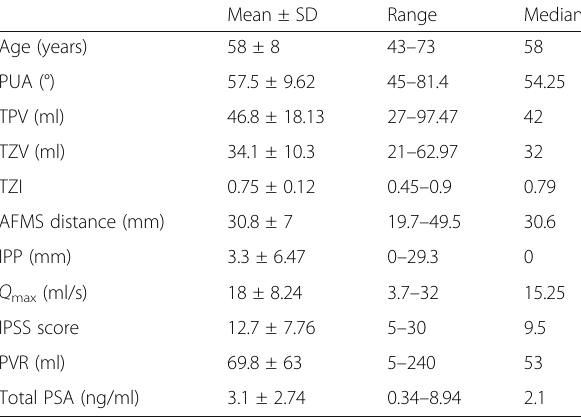
Table 1 Mean ± SD, range and median values of age, PUA, TPV, TZV, TZI, AFMS distance, IPP, Q max , IPSS, and total PSA